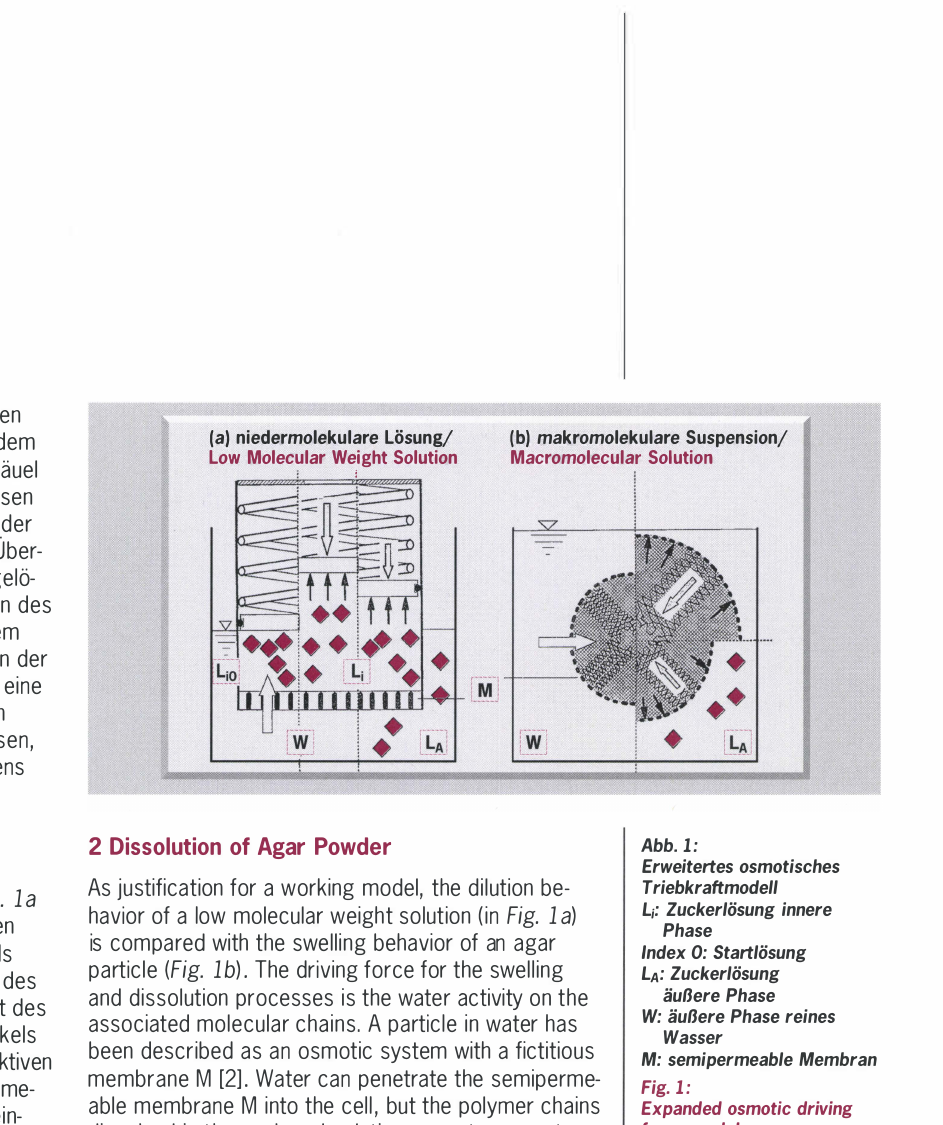
Fig.l: Expanded osmotic